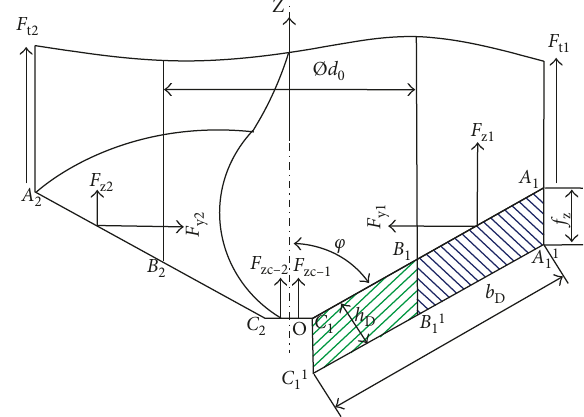
Figure 3: Geometry of the drill point